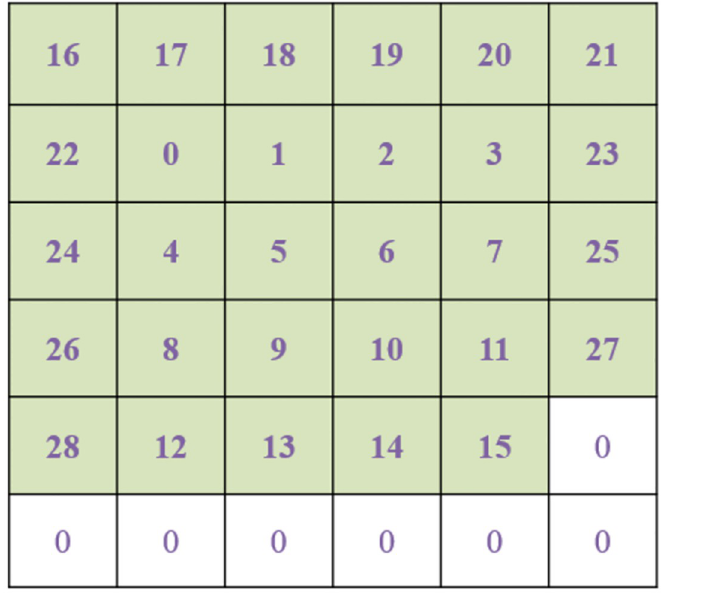
Fig 6. A 6 × 6 data grid for a 29-bit CAN